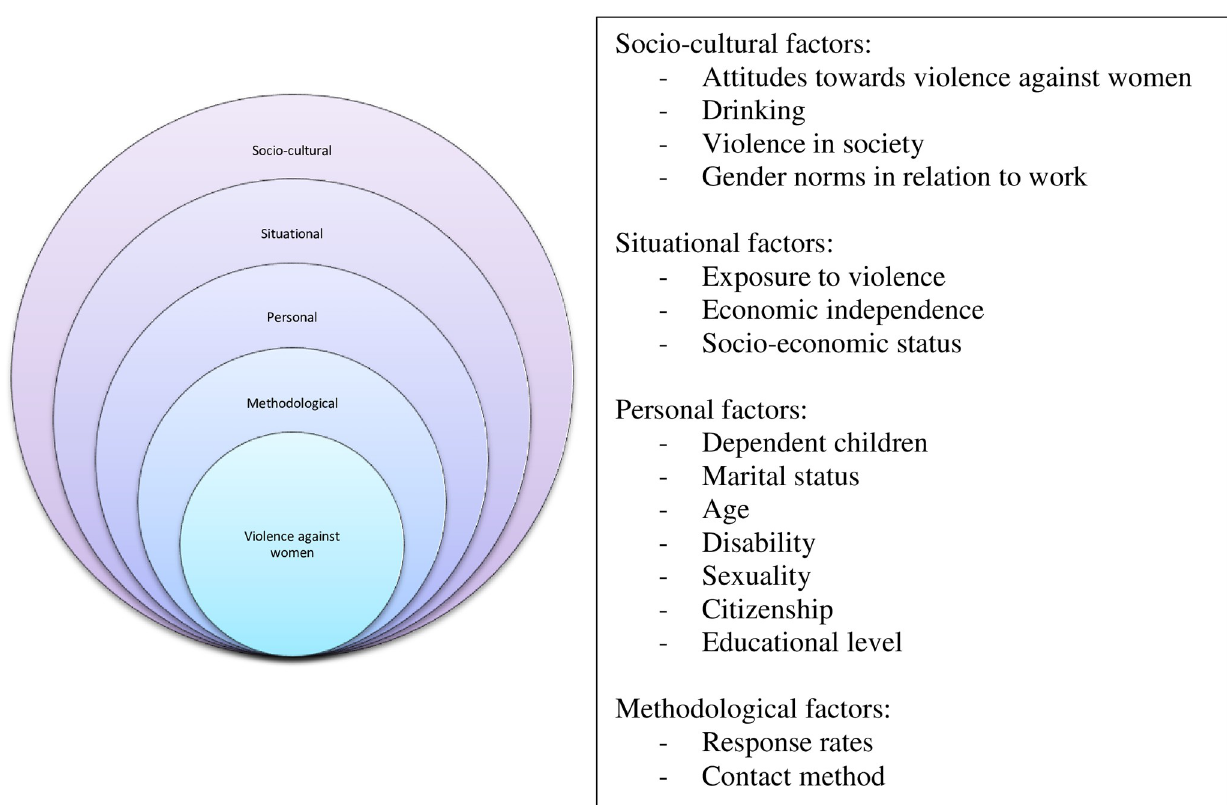
Fig 2. Multi-level factors affecting violence against women. Source: based on Heise (1998).